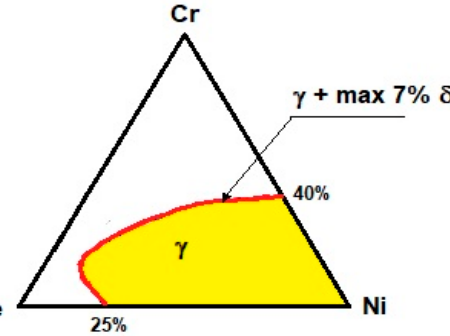
Figure 2. Equilibrium diagram Ni-Fe-Cr (based on [23]).